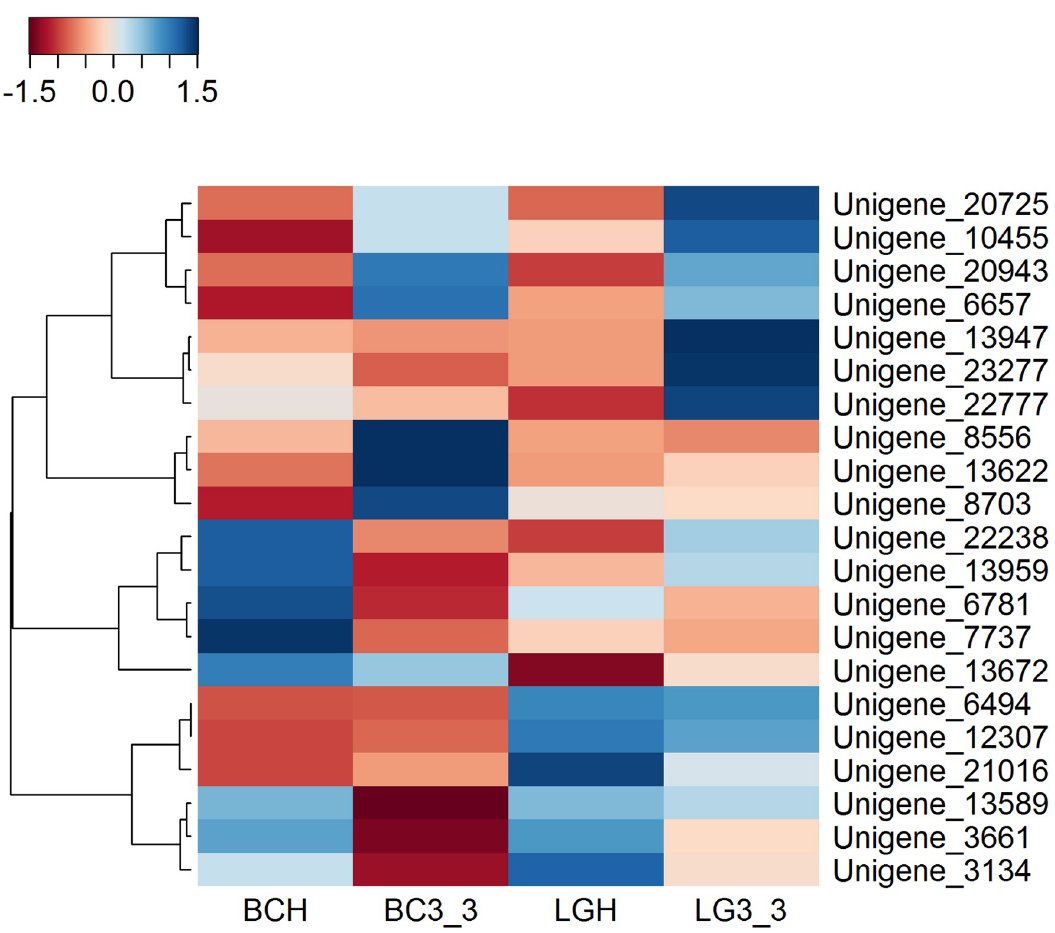
Fig 6. Heat map showing the expression of the 21 candidate unigenes identified as having a potential role in regulating changes in post-harvest firmness in ‘Bluecrop’ and ‘Legacy’. The colour scale represents FPKM normalized expression levels, the rows represent each unigene and the columns represent each cultivar and time point. BC indicates ‘Bluecrop’, LG indicates ‘Legacy’, H indicates harvest and 3_3 indicates 24 days